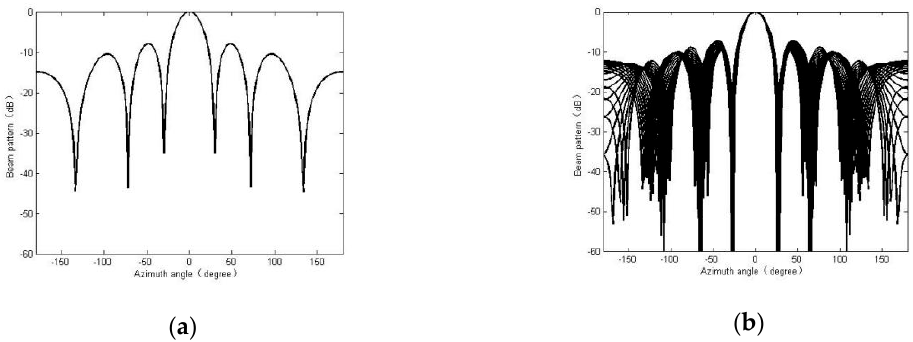
Figure 1. Experimental comparison of the optimal focusing frequency at 2760 Hz. ( a ) Narrowband beam pattern for the optimal focusing frequency; ( b ) broadband beam pattern focused on the optimal focusing frequency.